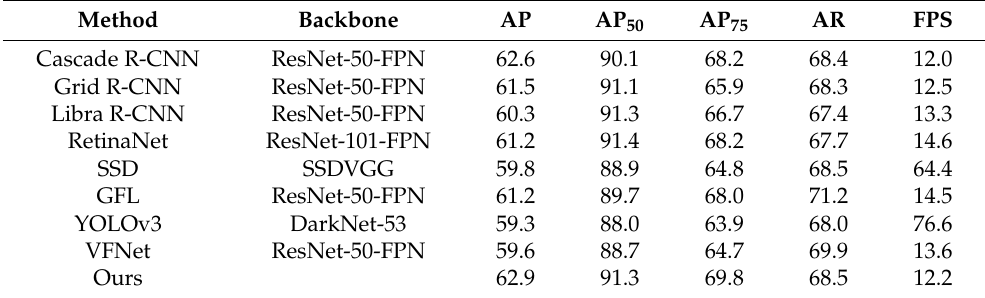
Table 3. Detection results of different detection frameworks. AP and AR are average precision and average recall, respectively. AP 50 and AP 75 stand for the AP under Intersection over Union thresholds of 0.5 and 0.75, respectively. FPS represents frames per second. (unit: %).